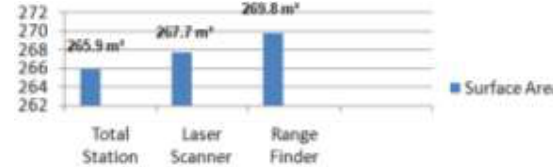
Figure 8. Equipment comparison based on model surface area